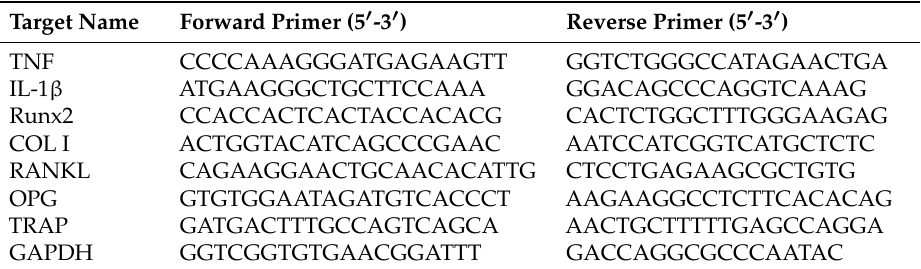
Table 2. Mouse primer sequences. TNF: tumor necrosis factor; IL: interleukin; COL I: type I collagen; RANKL: receptor activator of nuclear factor kappa-B ligand; OPG: osteoprotegerin; TRAP: tartrate-resistant acid phosphatase; GAPDH: glyceraldehyde 3-phosphate